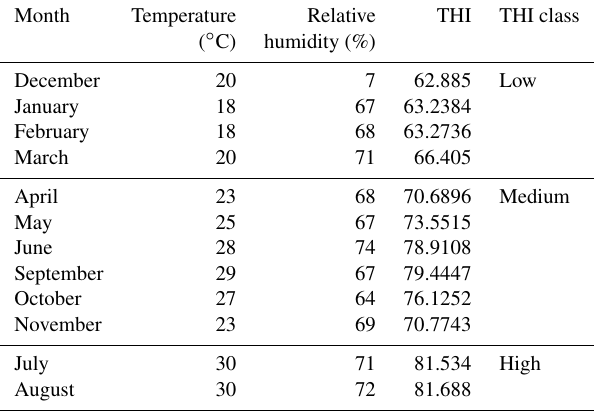
Table 1. Monthly average temperature in 2019, relative humidity, and temperature–humidity index (THI) at the Mersa Matrouh mete- orological